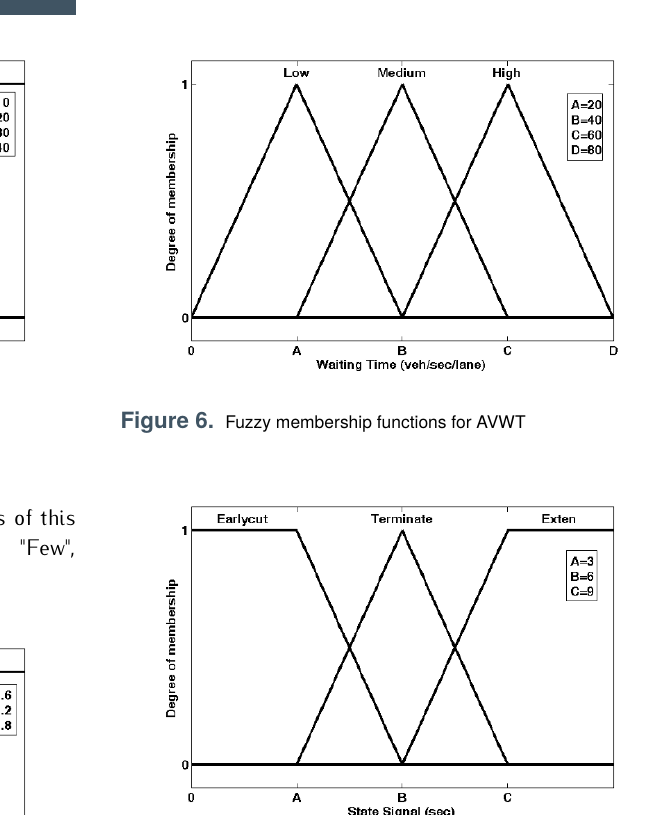
Figure 7. Fuzzy membership function for